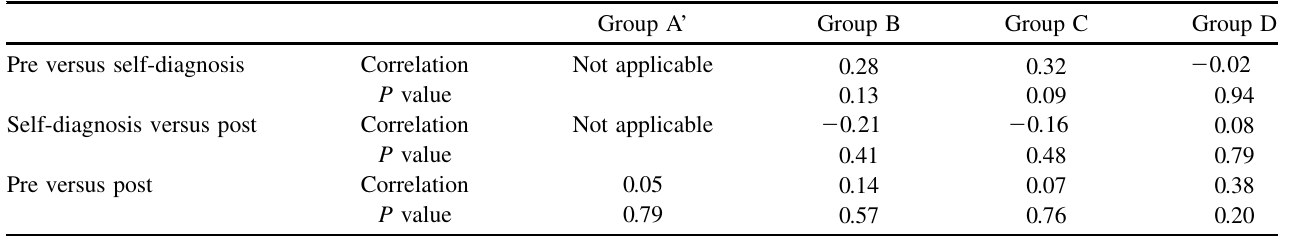
TABLE XVI. Within-group correlations—Presentation